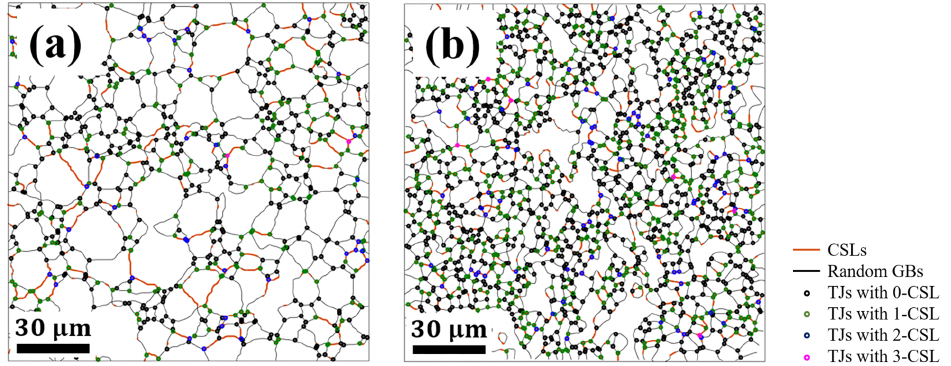
Figure 7. CSL grain boundaries ( Σ ≤ 49), random grain boundaries and different triple junction structures (with different numbers of connected CSLs) in the selected area of the pellets: ( a ) LG and ( b )